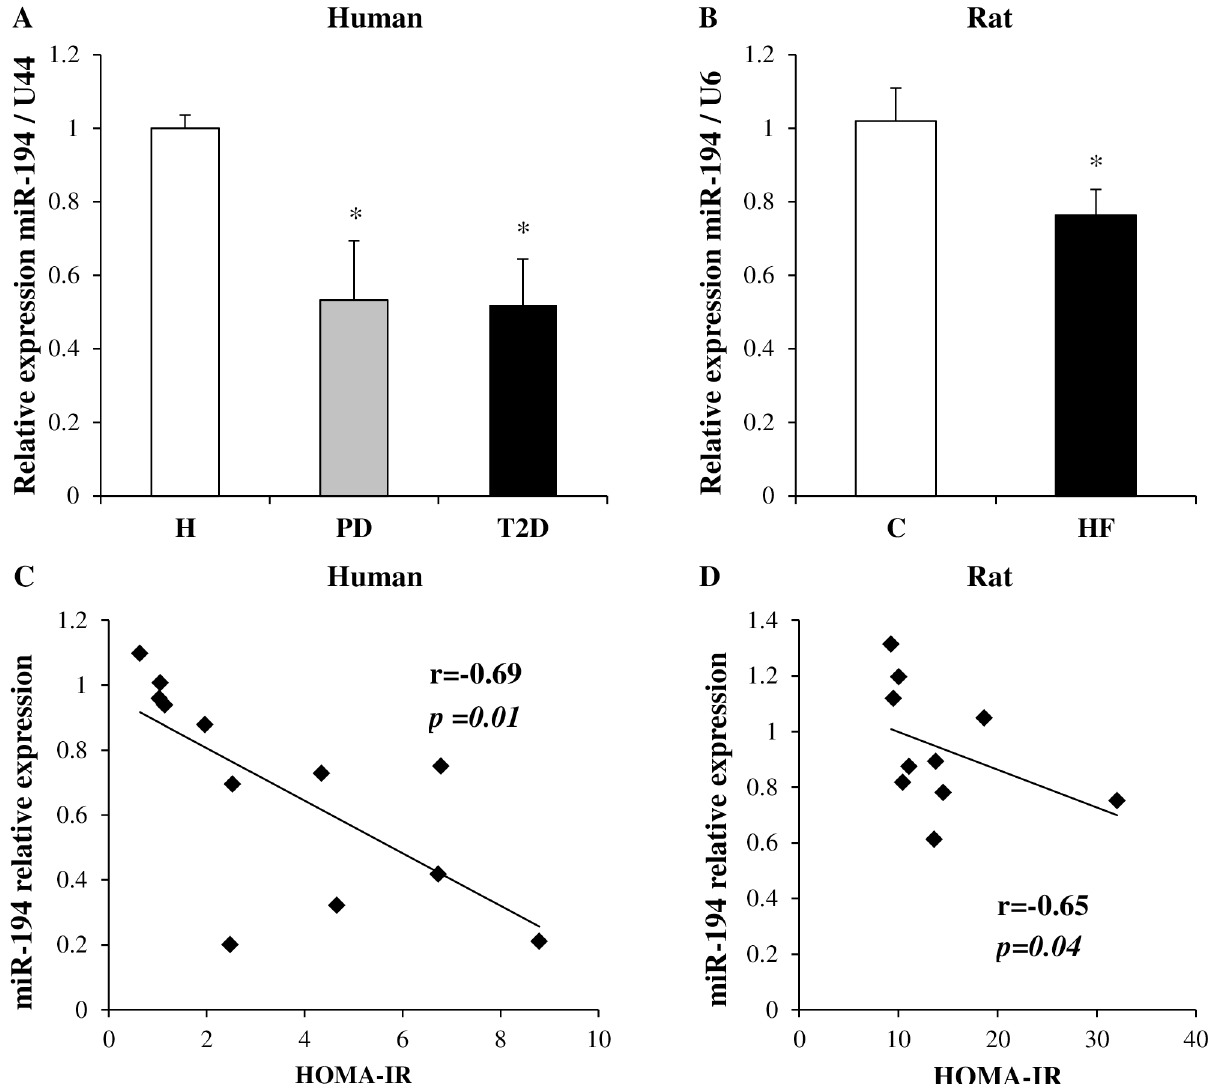
Fig 1. miR-194 expression in the skeletal muscle of human participants and rat offspring and correlations with HOMA-IR. miR-194 expression was validated by qPCR in human (A) and rat samples (B) (n = 4 – 6 per group). Values are expressed as mean ± SEM. P -values were determined using 1-way ANOVA followed by Student-Newman-Keuls post-hoc test for human data ( * p < 0.05 vs healthy), or Student ’ s t-test for rat data ( * p < 0.05 vs control). Correlation between miR-194 expression and HOMA-IR in human (C) and rat (D) was assessed using Pearson ’ s or Spearman ’ s correlation test as appropriate. R and p-values are indicated on the